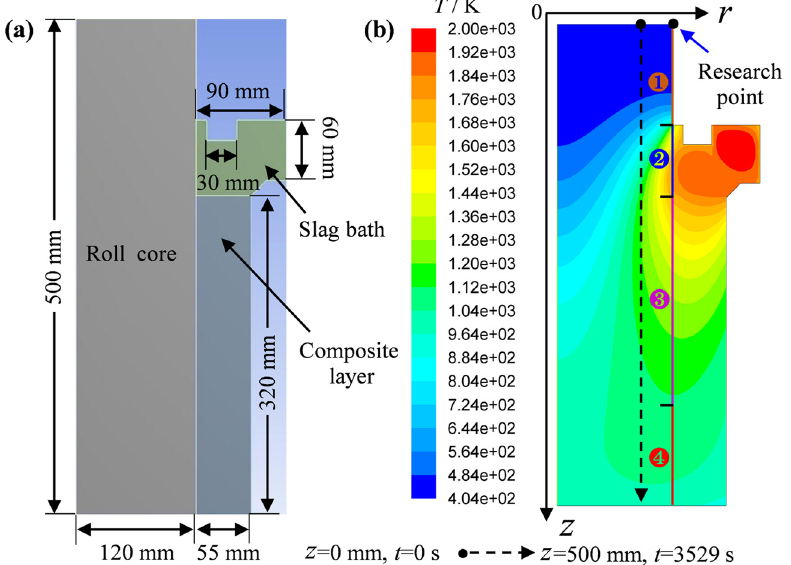
Figure 2: The ( a ) geometric model and ( b ) temperature distribution of the composite billet.